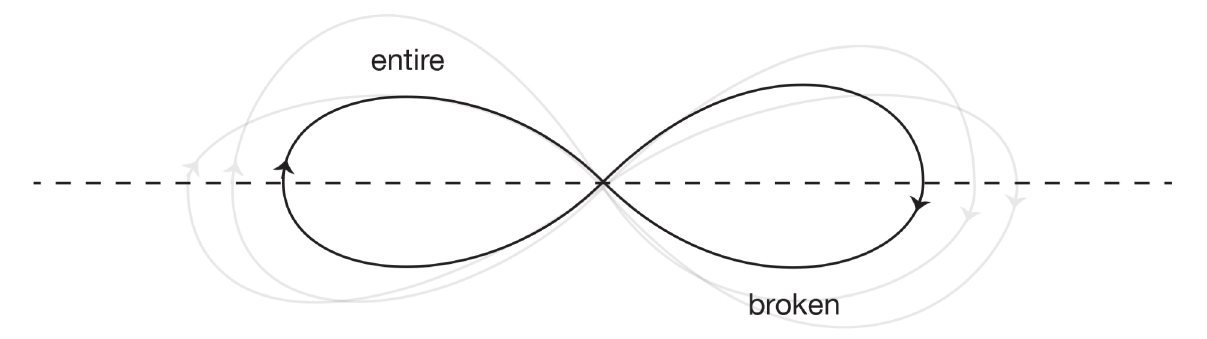
Figure 6 | Self-Healing Thing – Internal decision